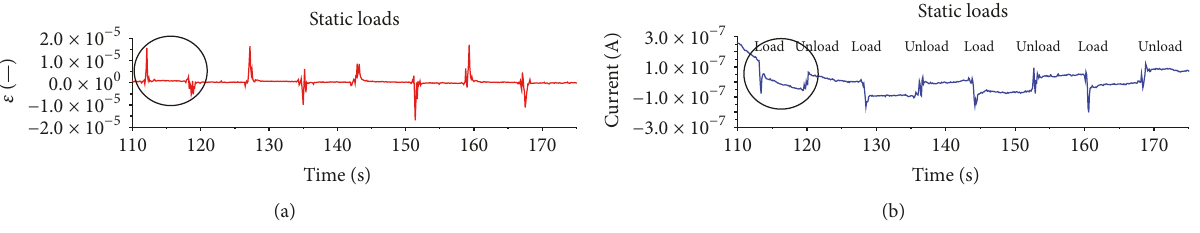
Figure 11: Time histories of average strain (a) and measured electrical current (b) during static loading and unloading of the full-scale reinforced